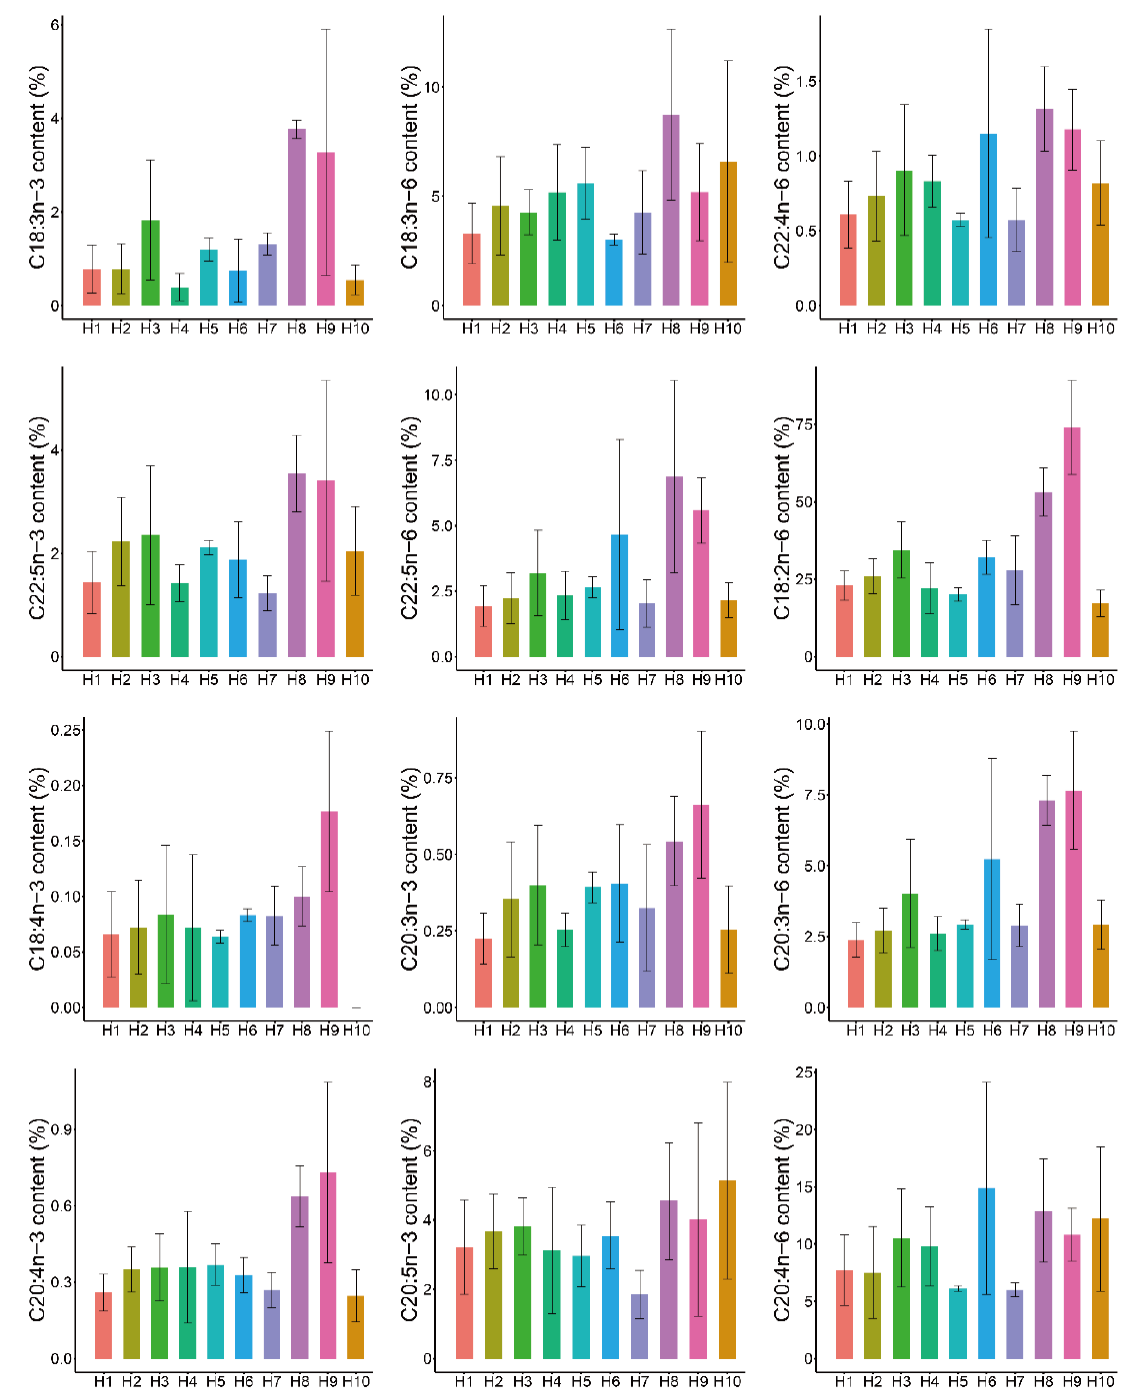
Figure 2. Bar plots showing the mean contents of PUFAs among ten genotype combinations. The genotype combination information and corresponding PUFA contents were shown in Supplementary Table S4. The bar heights represent the mean contents of PUFAs except the outliers. The whiskers are the standard deviations.